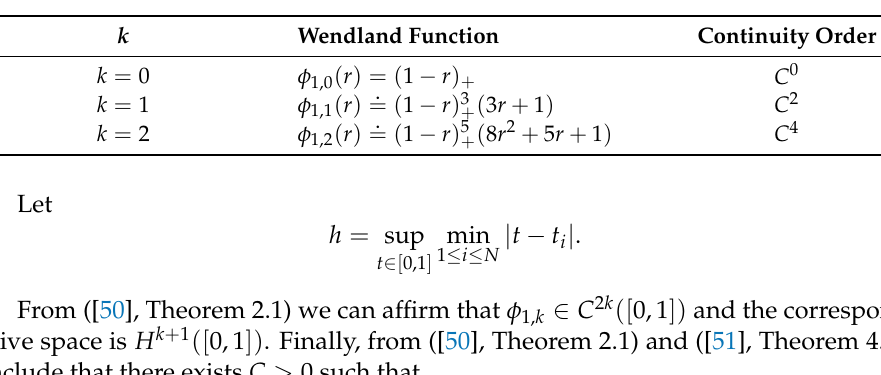
Table 1. The Wendland functions φ 1, k for k = 0,1,2 and its continuity